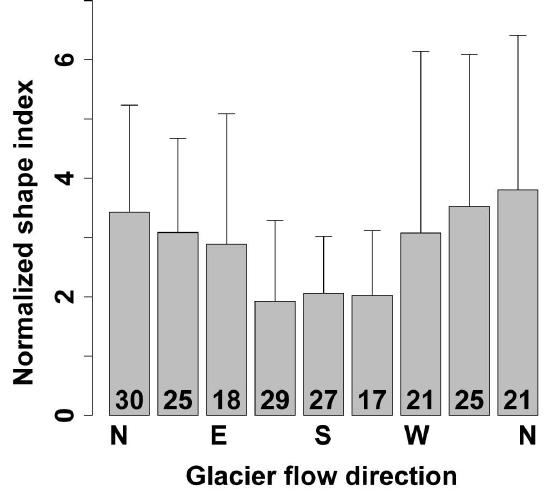
Fig. 8. Normalized shape index plotted against glacier flow direc- tion. Averages and standard deviations for an aspect bin of 40 ◦ are presented with the number of samples in each